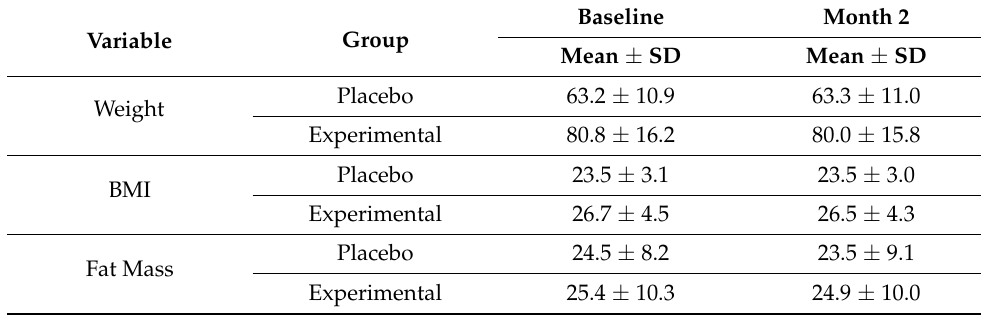
Table 3. Body composition values